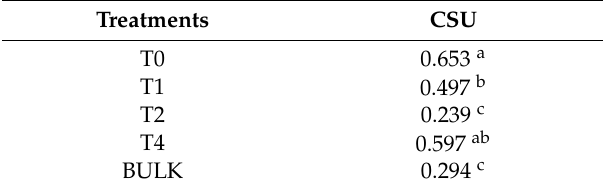
Table 3. Carbon source utilization profiles of the average of treatments sampled and variation within di ff erent inoculation levels. Treatments